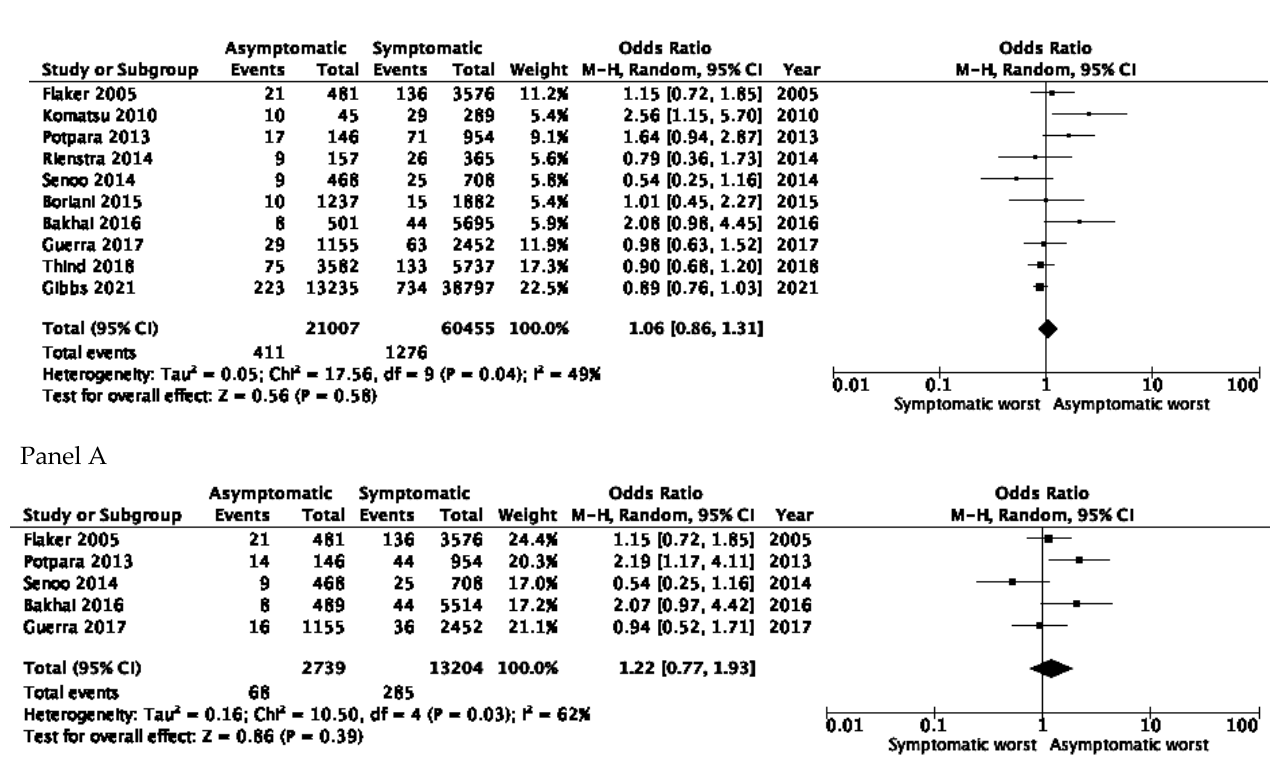
Figure 3. Stroke and thromboembolic events. Panel ( A ) Thromboembolic events/stroke in asymptomatic and symptomatic AF patients. Panel ( B ) Stroke in asymptomatic and symptomatic AF patients.